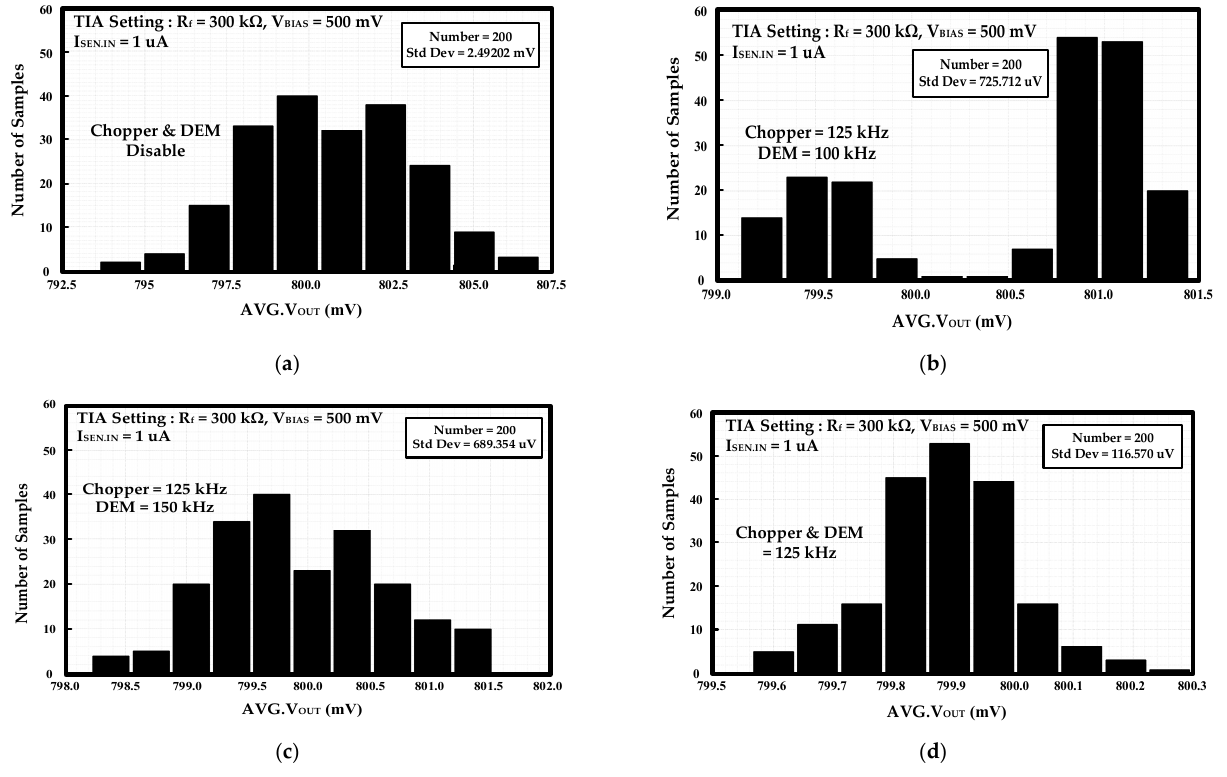
Figure 14. Mismatch simulation results when the chopper and DEM were ( a ) disabled; used different frequency ( b ) f ch = 125 kHz, DEM clock = 100 kHz; ( c ) f ch = 125 kHz, DEM clock = 150 kHz; used same frequency ( d ) f ch = DEM clock = 125 kHz. As shown in Figure 14b,c, the standard deviation of the TIA output was 0.75 to 0.68 mV. Table 2. Performance summary comparison between the proposed potentiostat readout circuit and previous studies. The different chopper frequency and DEM frequency were used, and this may introduce performance degradation due to the IDM between the chopper and DEM frequencies.